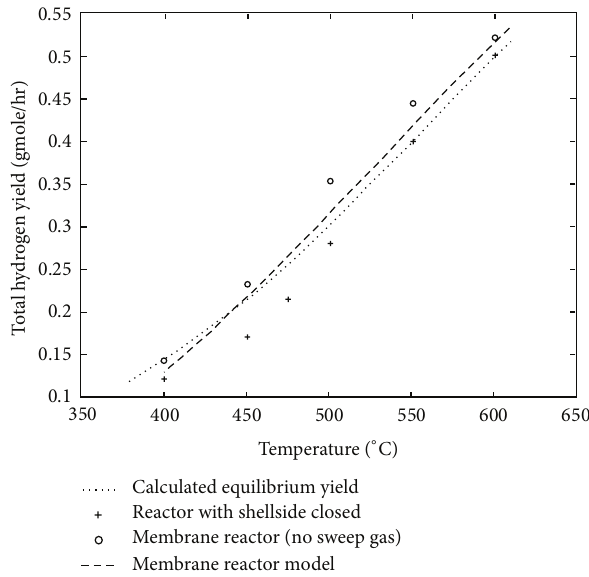
Figure5:Modelingresultsoflandfillgas-steamreformersforsyngas production and SOFC continuous operation. Molar flowrate data in Figure 7: Experimental and modeling results of landfill gas-steam = 1.68 atm,feedcomposition:CH thereactionside(tubeside)( 𝑃 𝑇 reformers for syngas production and SOFC continuous operation. 4 : 𝑜 Total hydrogen yield